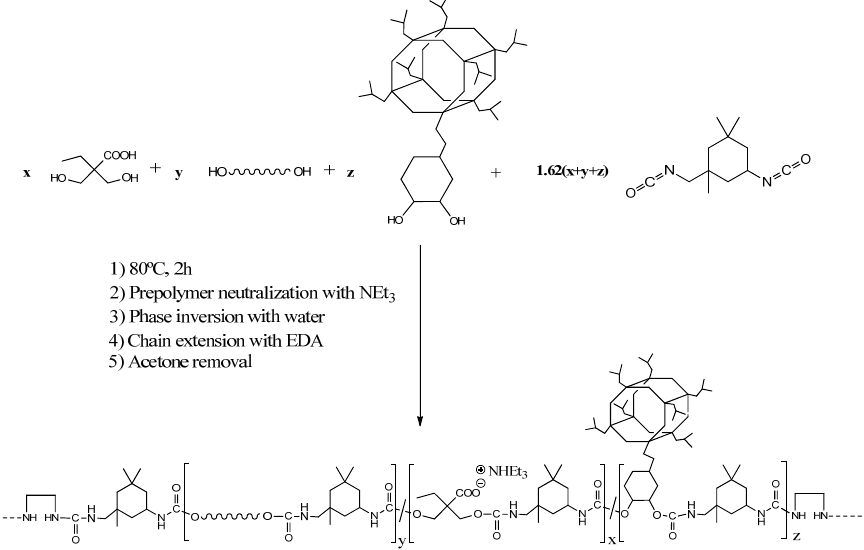
Figure 4. Synthesis scheme of the waterborne polyurethane-urea dispersions using POSS-OH as a co-polyol.